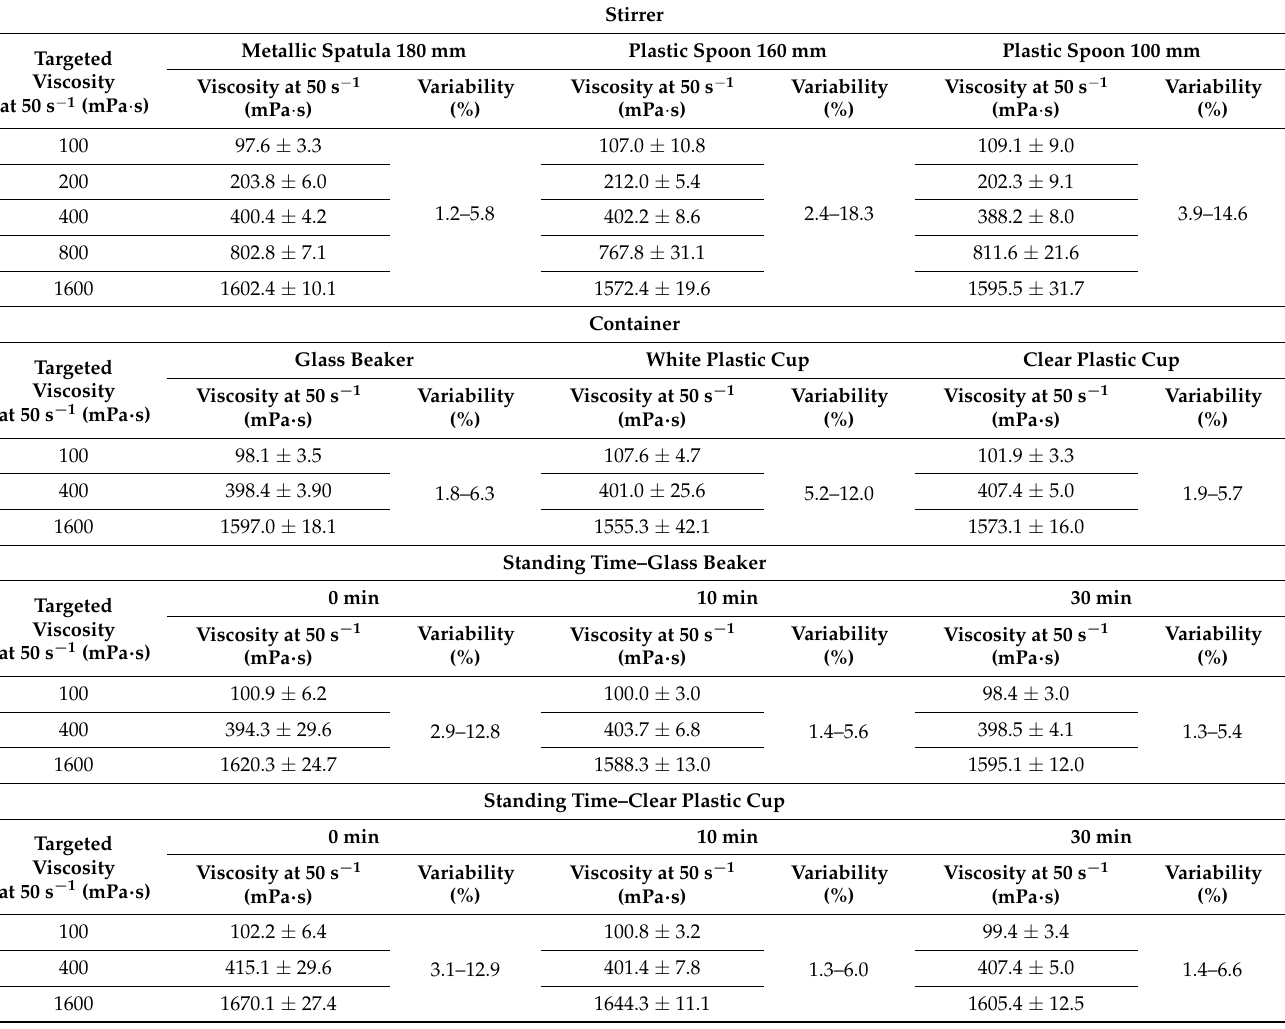
Table 3. Stirring conditions tested by the reference lab to harmonize the rheological protocol between laboratories: stirrer, container and standing time.